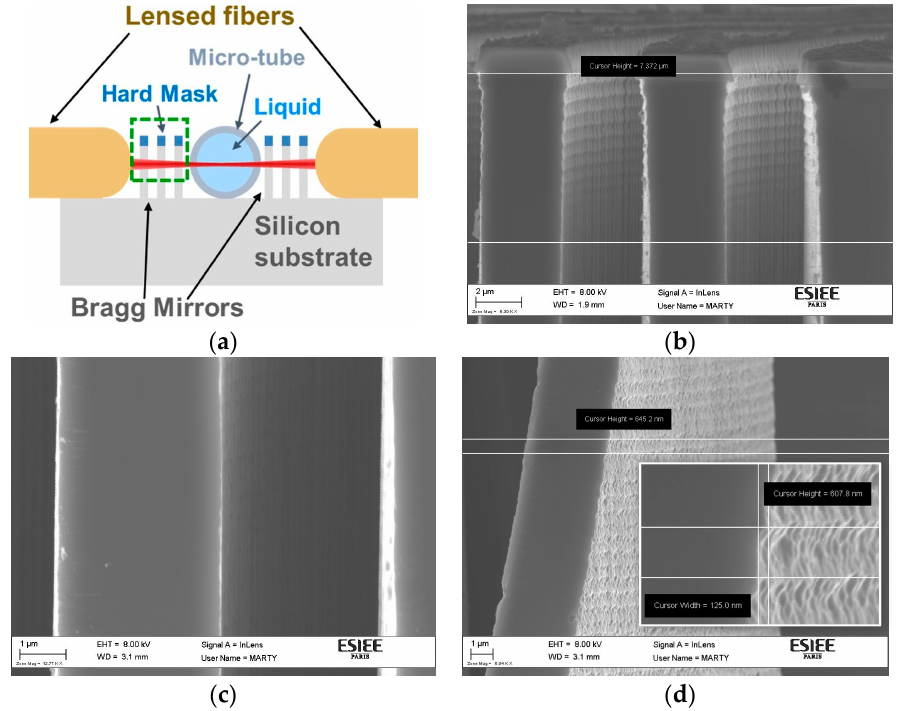
Figure 8. ( a ) Schematic diagram for the horizontal cross section of the device. ( b ) SEM image for the top part of one Bragg mirror indicated in schematic (a) by the dashed rectangle indicates the ARDSA phenomenon. ( c ) SEM image for the Bragg mirror at depth between 15 and 20 μ m , corresponds to region illuminated by the light beams from the fiber, indicates the attenuatted scalloping. ( d ) SEM image for the outer surface of the Bragg mirror wall. The inset is a zoom indicating the dimensions of the non-attenuated scalloping.